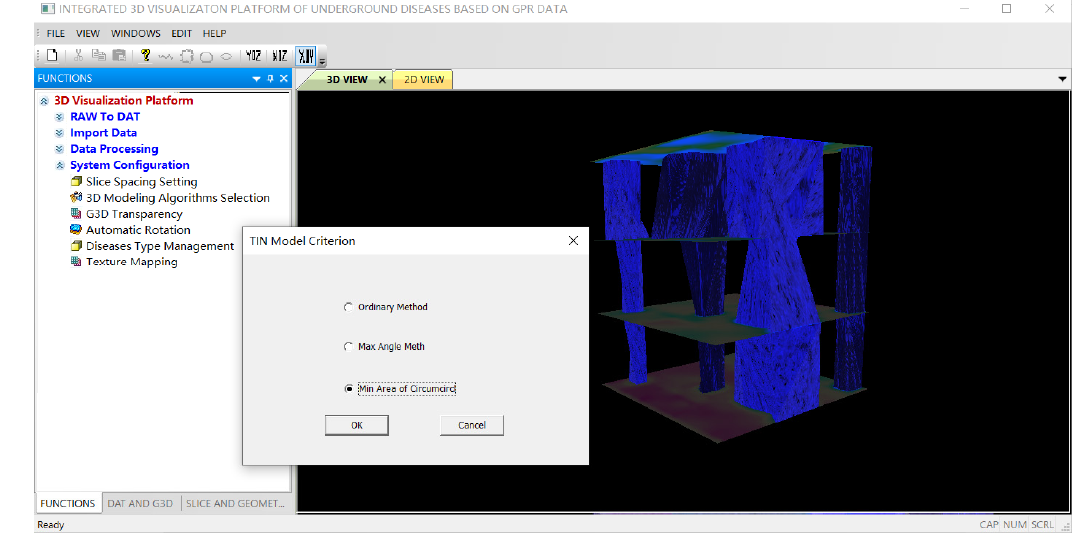
Figure 13. LC-TIN criterion configuration.